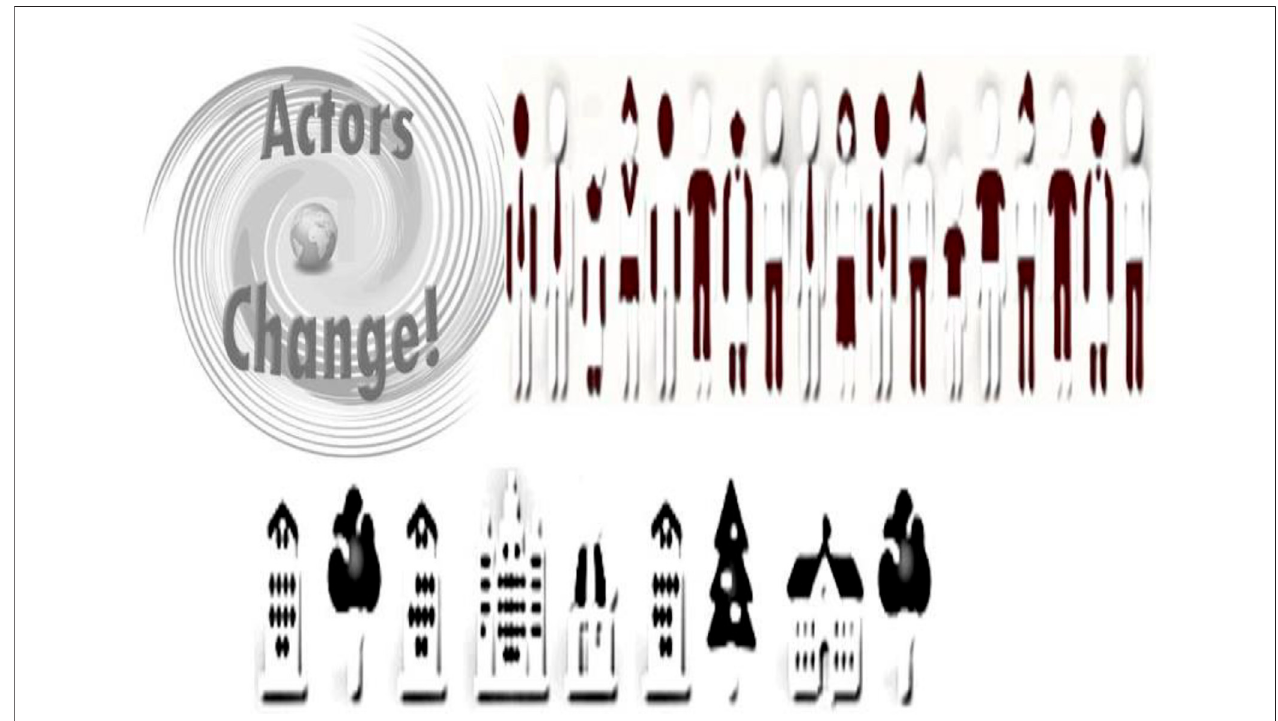
FIGURE 5 | Performers changes for circular economy platform. Source: Author own computations.